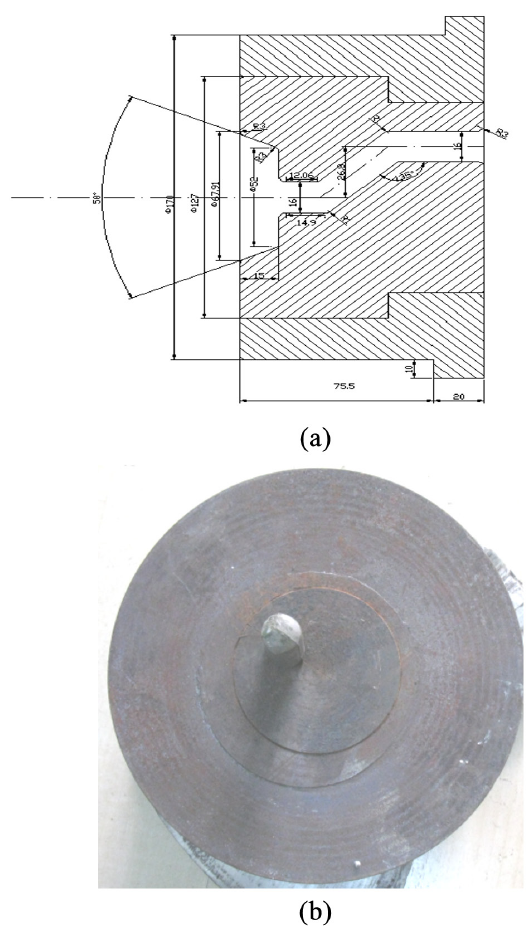
Figure 1. (a) Schematic diagram of an ES die, (b) processed ES